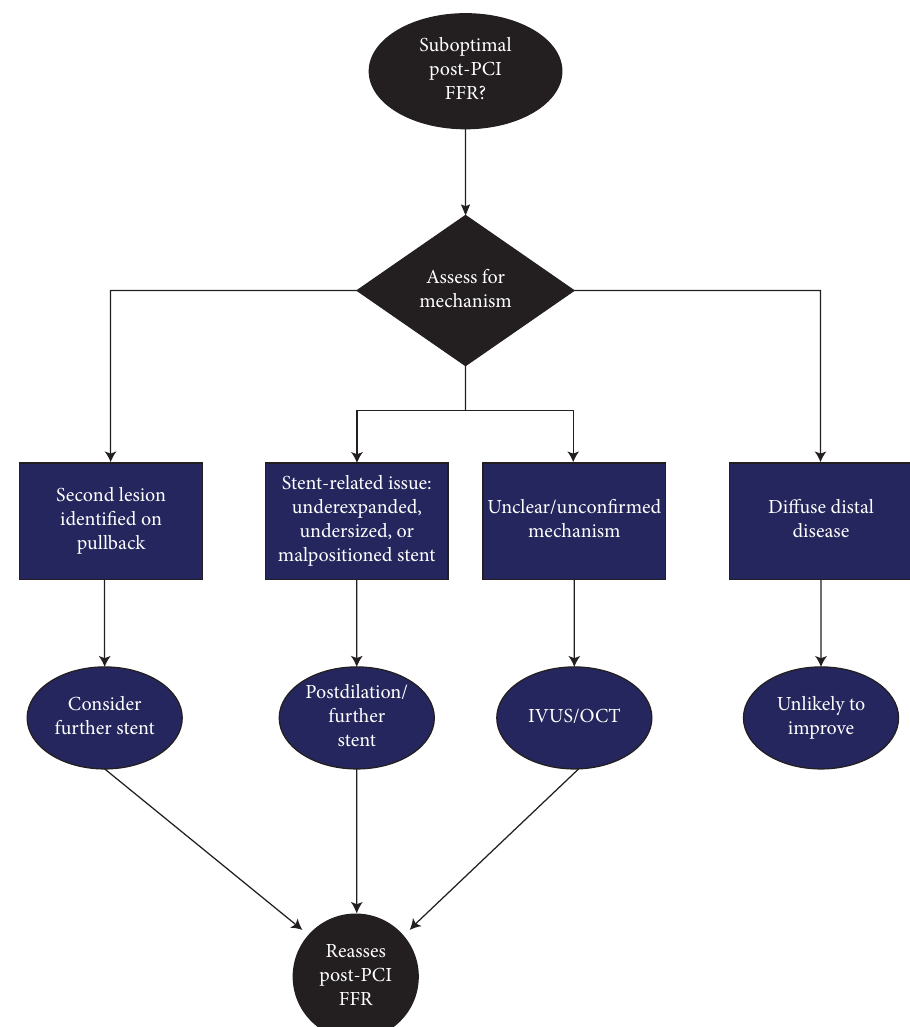
Figure 3: A simple schematic approach of interpretation of post-PCI